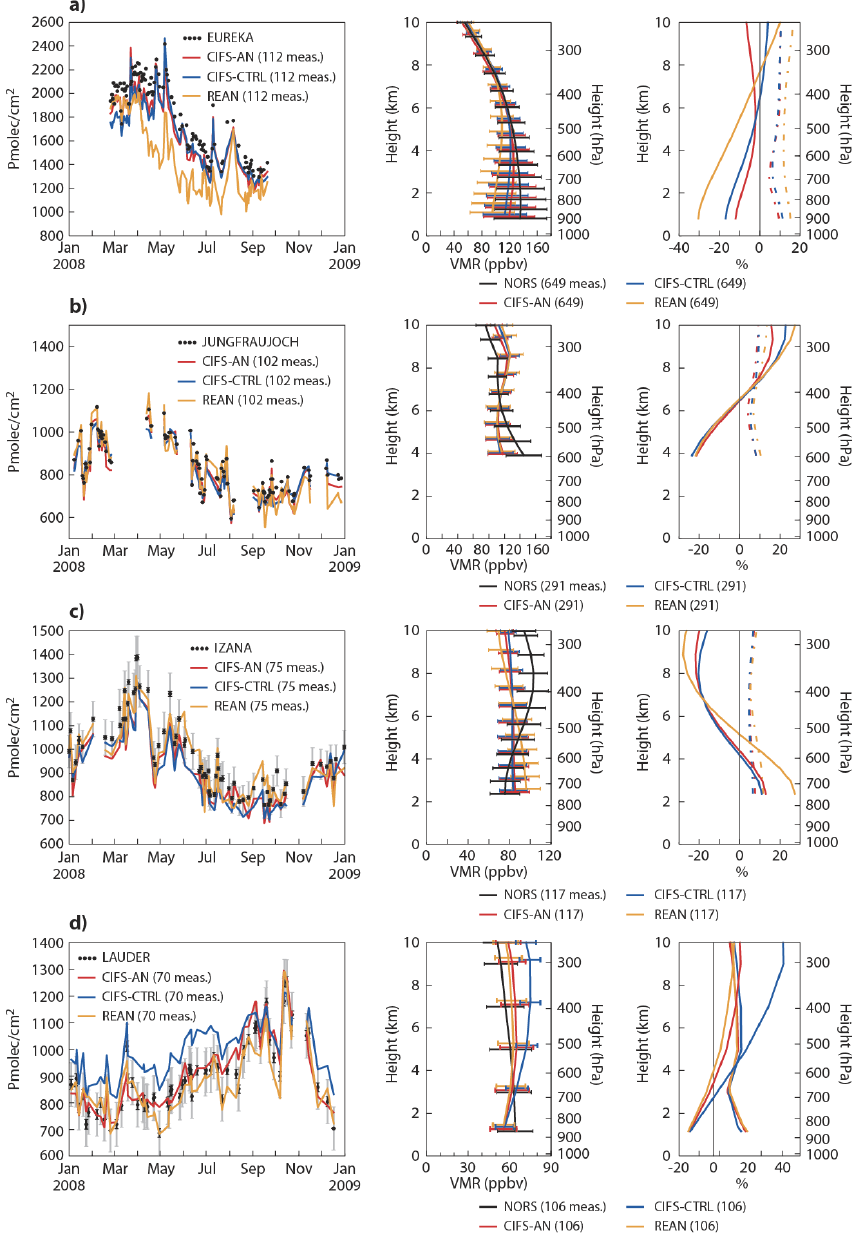
Figure 6. Time series of daily mean tropospheric CO columns (surface to 10km) in 10 15 moleculescm − 2 (left), annual mean CO volume mixing ratio profiles in ppbv (middle) and annual mean bias (model minus observation) profiles in % (right, with dashed lines for spread) for the year 2008 for four NDACC stations: (a) Eureka, (b) Jungfraujoch, (c) Izaña and (d) Lauder. CIFS-AN is shown in red, CIFS-CTRL in blue and REAN in